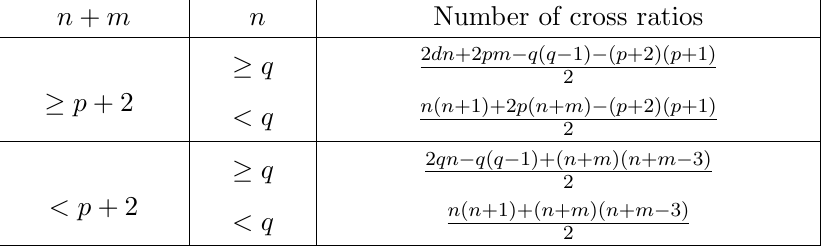
Table 1 . Number of cross ratios in (2.12): n and m are the numbers of bulk and defect operators respectively. Notice that the middle cases involve restrictions on the relation between dimension and codimension: p + 2 7 q + m